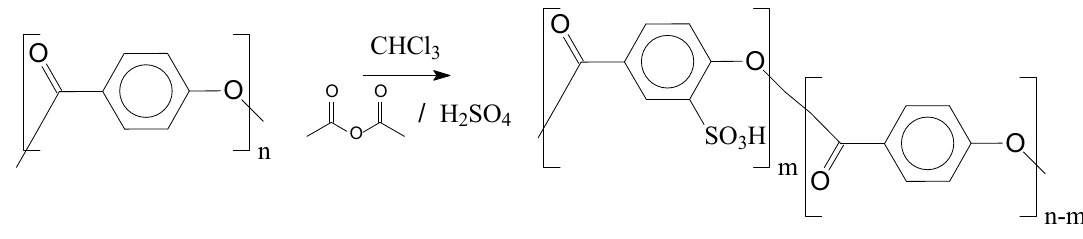
Figure 9. Poly(4-hydroxybenzoic acid) sulfonation.